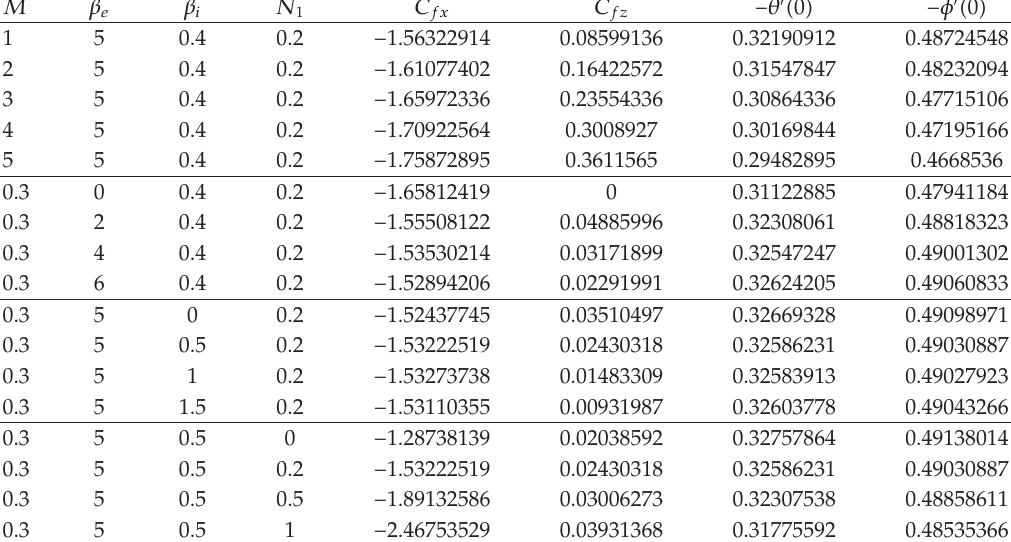
Table 3: The local Nusselt number − θ (cid:4) (cid:6) 0 (cid:7) , Sherwood number − φ (cid:4) (cid:6) 0 (cid:7) , and the wall shear stresses C fx (cid:8) (cid:6) 1 (cid:9) N (cid:7) f (cid:4)(cid:4) (cid:6) 0 (cid:7) and C (cid:8) (cid:6) 1 (cid:9) N (cid:7) g (cid:4) (cid:6) 0 (cid:7) for various values of β 1 fz 1